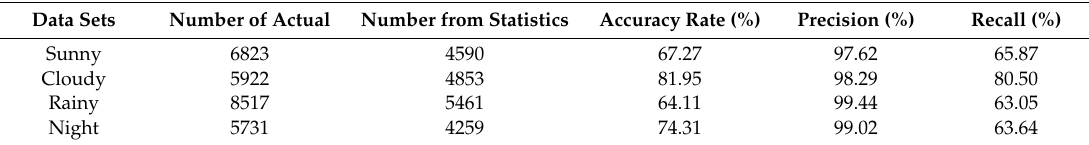
Table 3. YOLO multi-environment traffic statistics.